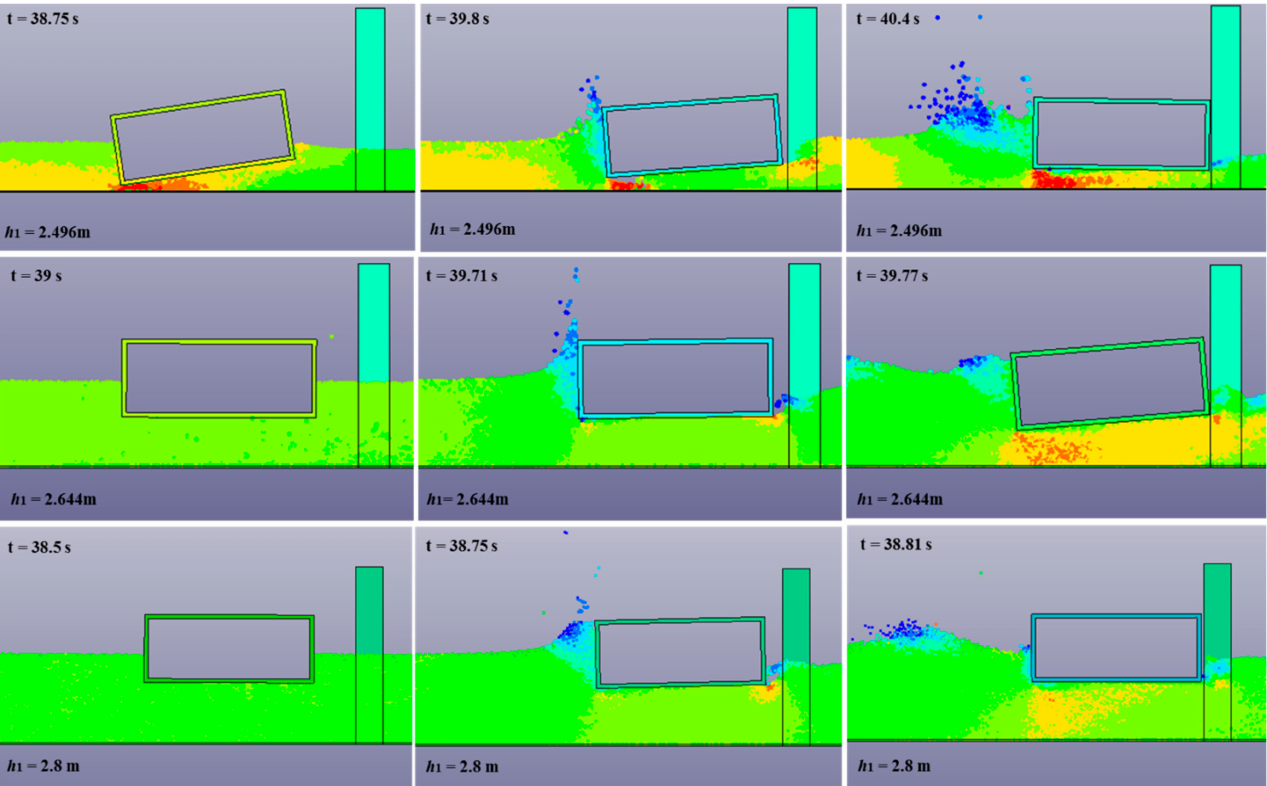
Figure 17. Snapshots of debris-tsunami interaction and impact on the column. Numerical results of free debris for T erf = 40 s and three water depths with h 1 = 2.496 ( top ), 2.664 ( center ) and 2.8 m ( bottom